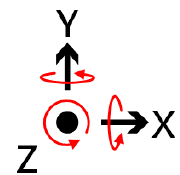
Figure 15. Gyro rotation direction diagram.